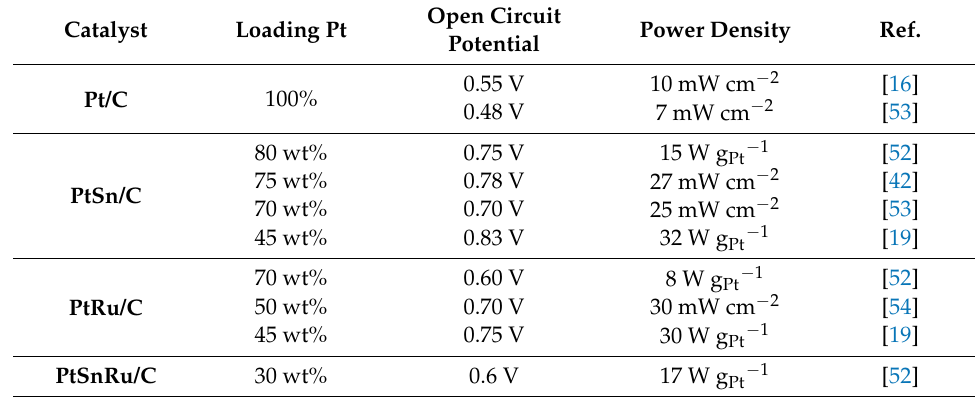
Table 3. Open circuit potential and power density values of different catalysts found in the literature.